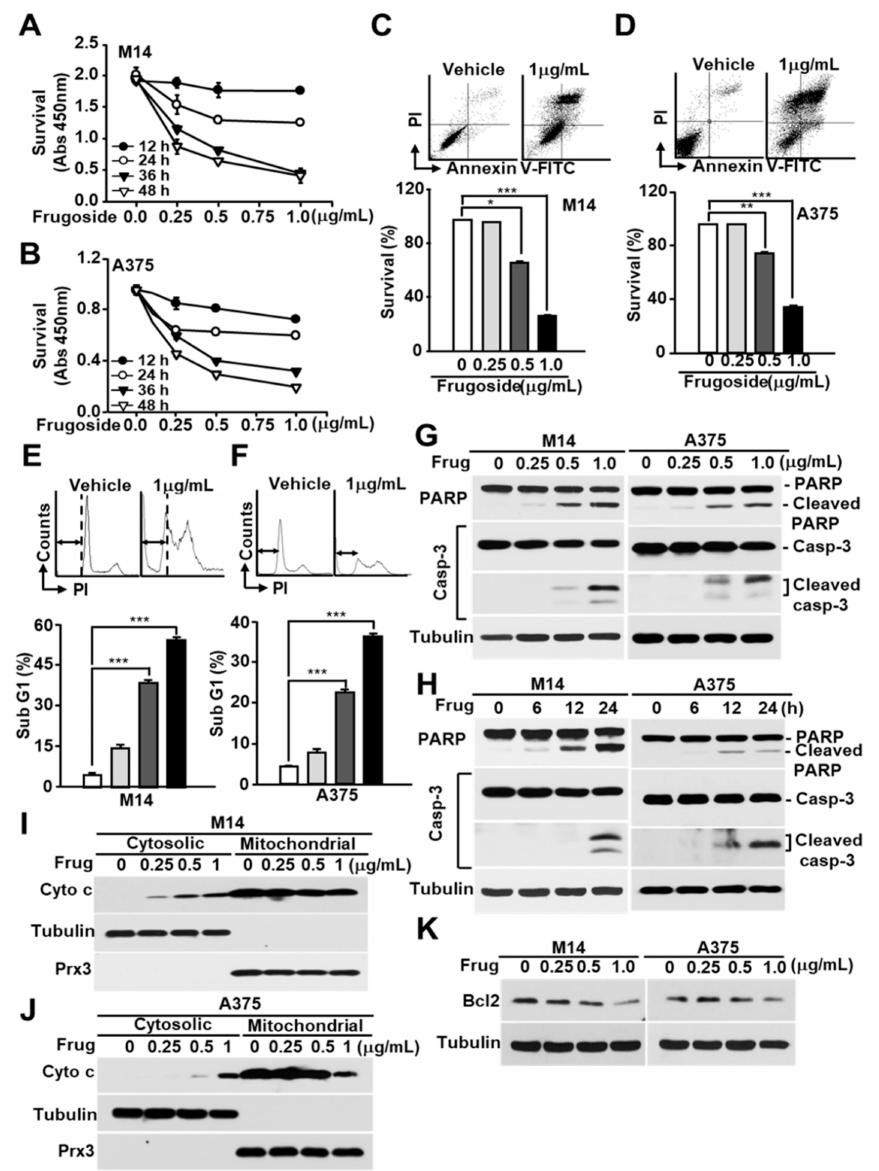
Figure 2. Frugoside induces mitochondria-mediated cell death in melanoma cells. ( A , B ) M14 ( A ) and A375 ( B ) cells were treated with frugoside at the indicated time and dose. The cytotoxicity level was measured by the CCK-8 assay. ( C – F ) M14 and A375 cells were treated with frugoside at the indicated dose for 24 h. The viability of frugoside-treated M14 ( C ) and A375 ( D ) cells was determined by a fluorescence-activated cell sorting (FACS) analysis after propidium iodide (PI) / Annexin V-fluorescein isothiocyanate (V-FITC) staining. The apoptotic cell population (Sub-G1) was measured by PI staining and a flow cytometry analysis in frugoside-treated M14 ( E ) and A375 ( F ) cells. ( G , H ) M14 and A375 cells were treated with various doses of frugoside for 24 h ( G ) or for the indicated periods ( H ; 0.5 µ g / mL). The lysates were assessed by a western blot analysis using antibodies against the indicated proteins. ( I , J ) M14 ( I ) and A375 ( J ) cells were treated with frugoside in a dose-dependent manner for 24 h. Cytosolic and mitochondrial fractions were prepared from the frugoside treated cells. The identity of the cytosolic and mitochondrial fractions was verified by the specific marker proteins, tubulin and Prx3. ( K ) M14 and A375 cells were treated with frugoside at the indicated doses for 24 h. The cells were analyzed by a western blot analysis with antibodies against Bcl2 and tubulin. p values were derived to assess statistical significance and are indicated as follows: * p < 0.05; ** p < 0.01; and *** p <